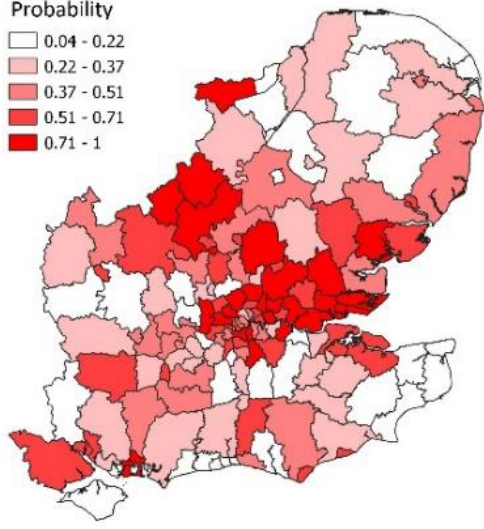
Table 4. Ranked Probability Score (RPS) (Posterior Means by Week and Model).